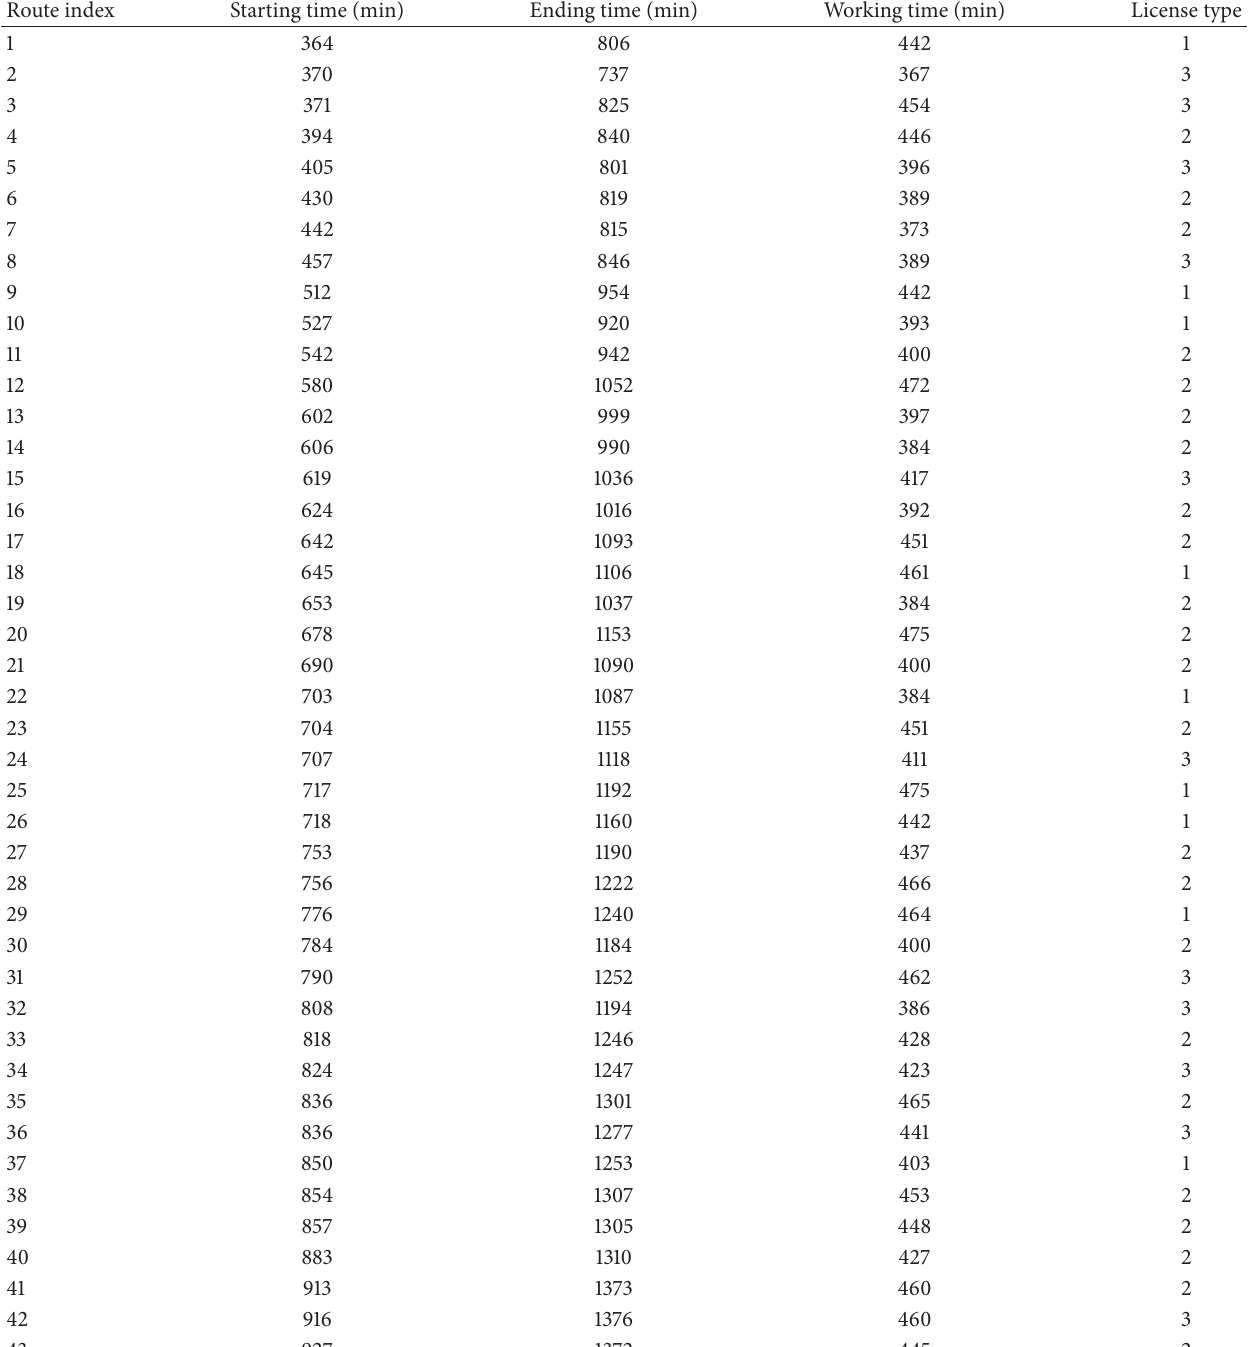
Table 1: Crew route